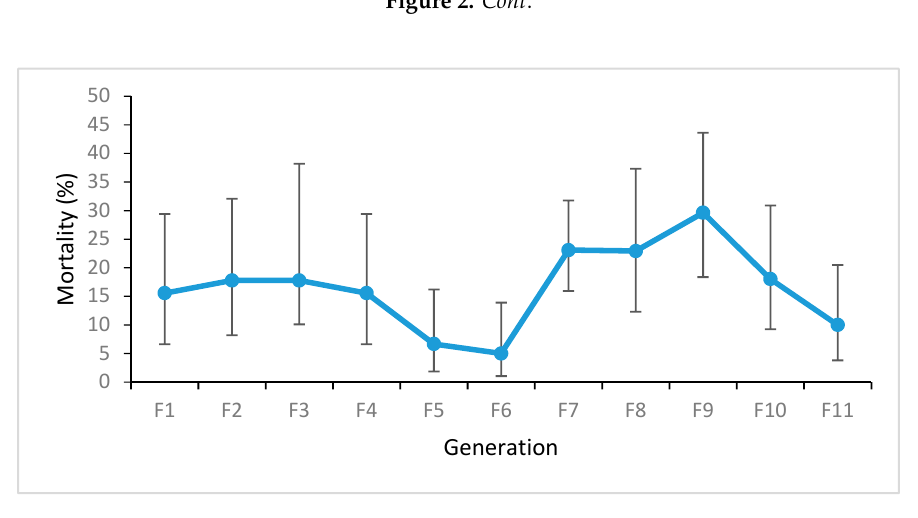
Figure 2. Cont . Insects 2020 , 11 , x FOR PEER REVIEW